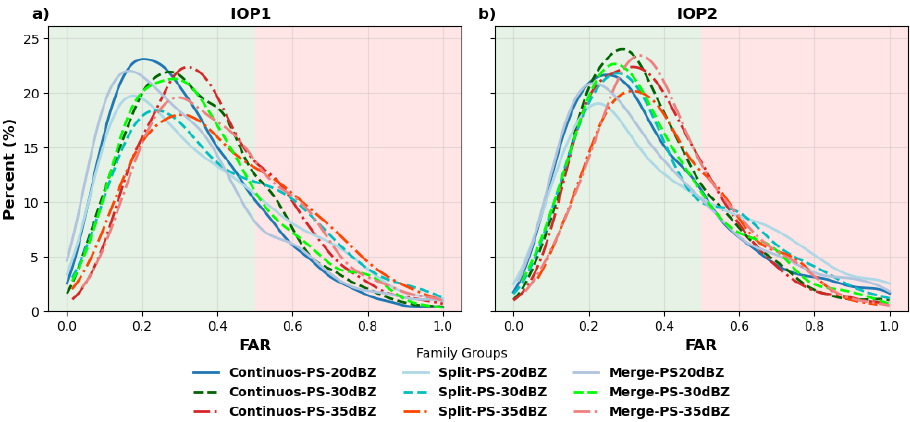
Figure 12. FAR relative frequency histogram for each detection threshold and interaction class (continuous, merges, and splits) for IOP 1 ( a ) and IOP2 ( b